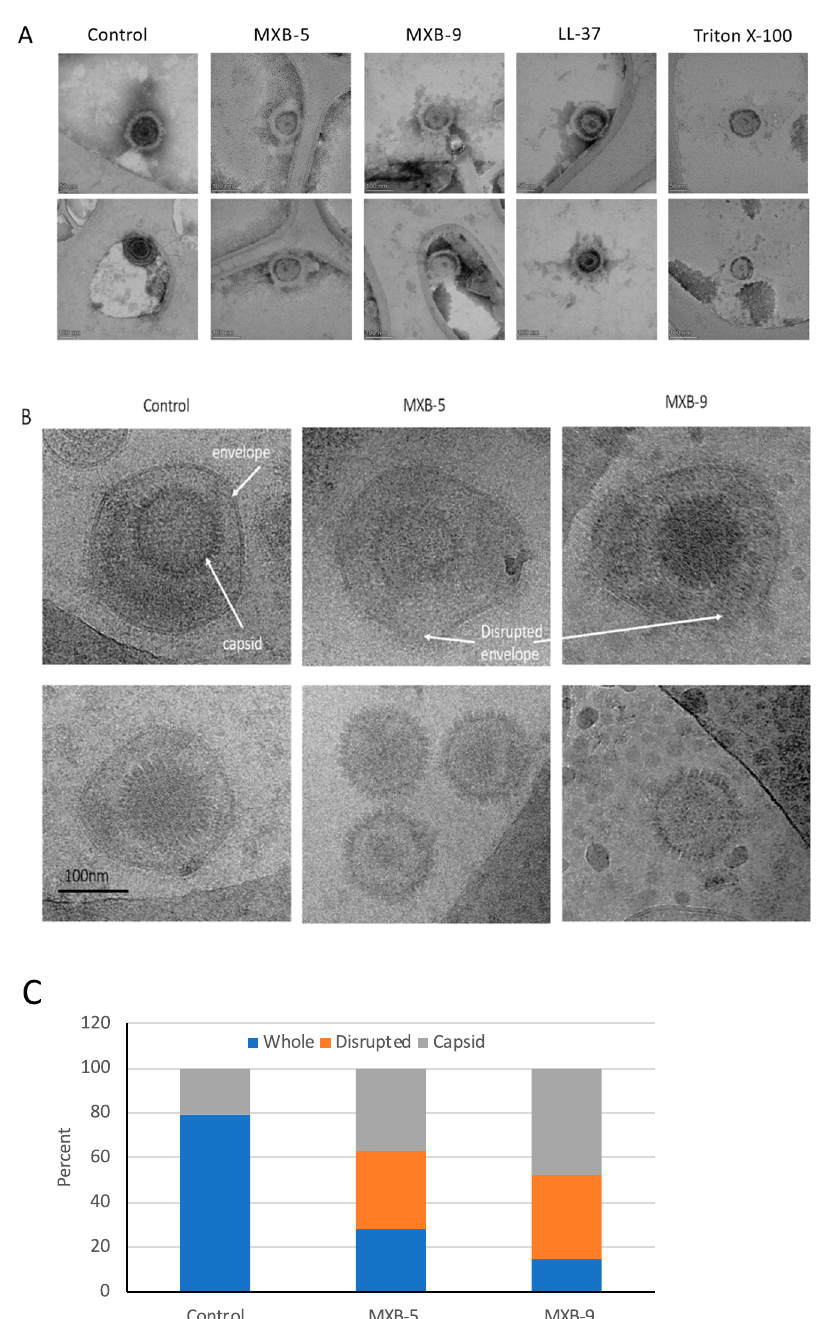
Figure 3. Transmission electron microscope imaging of peptoid-treated HSV-1 vs. controls and comparative analysis of results. Virus was treated for 2 h at 37 °C followed by preparation for EM imaging as described in Materials and Methods. ( A ) Negative stained EM. ( B ) Cryo-EM. Visible in the control samples are the viral envelope and intact capsid (both panels). In the samples treated with the peptoids we observe both disrupted envelopes (top panels) and naked capsids (bottom panels). ( C ) Quantification of relative amounts of whole virus, disrupted envelopes and naked capsids that were observed in the cryo-EM